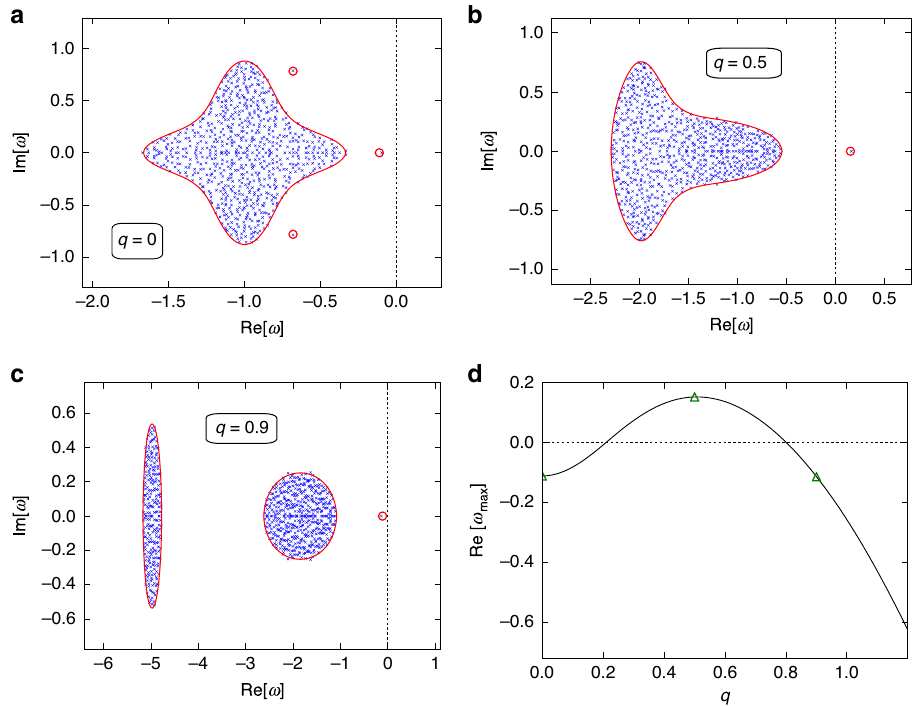
Fig. 2 Eigenvalue spectra of the stability matrices in Fig. 1. In May ’ s original model, the eigenvalues all lay uniformly within a circle in the complex plane. In our model, the circle is warped and split into more complicated shapes. Also, a small number of outlier eigenvalues now stray from the bulk. Eigenvalues of computer-generated random matrices M q are shown as blue crosses. They are compared to theoretical predictions for the boundary of the bulk region (red solid line) and theoretical predictions for the outliers (open red circles). For q = 0, all of the eigenvalues have negative real part (panel a ) — the equilibrium is stable in the non-spatial ecosystem. For disturbances with larger wavenumber q , one of the eigenvalues crosses the real axis (panel b ). The equilibrium is unstable against such perturbations. If the wavenumber q is larger still, the rightmost eigenvalue returns to the negative half-plane (panel c ). This is characteristic of a Turing instability 33 — the equilibrium is unstable with respect to disturbances of a fi nite range of wavelengths. This is shown in panel d , where we plot the real part of the rightmost eigenvalue as a function of q . The equilibrium is unstable against perturbations of wavenumber q whenever Re ½ ω max (cid:2) > 0. The green triangles mark the wavenumbers from panels ( a – c